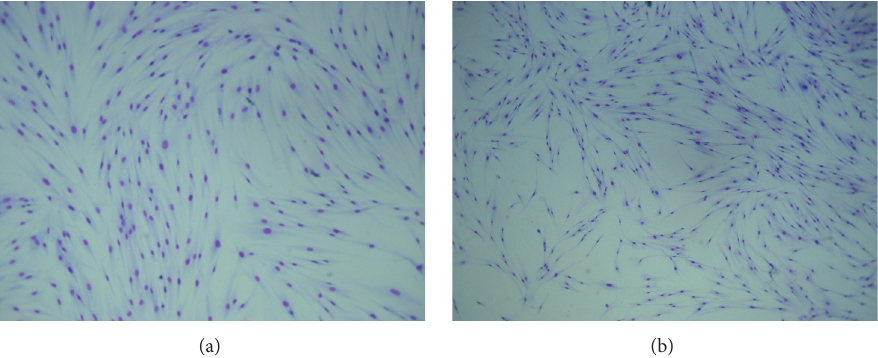
Figure 6: Optic microscope images of oral fibroblast (HGF-1) treated with (a) HAP and (b) HAPEu10% nanoparticles. After their treatment, no changes in morphology and size are appreciated; however, a decreased viability was observed. Treatment conditions are the same as those describe in Section